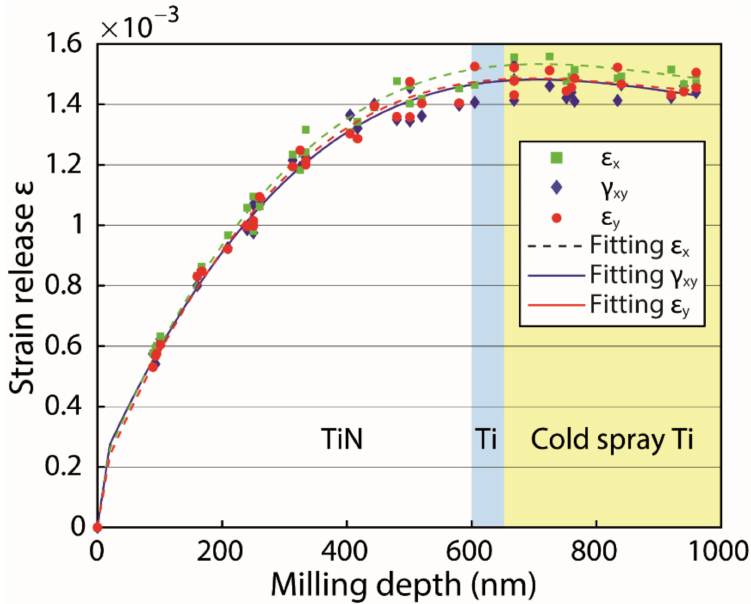
Figure 12. The depth–strain release curves of TiN/Ti